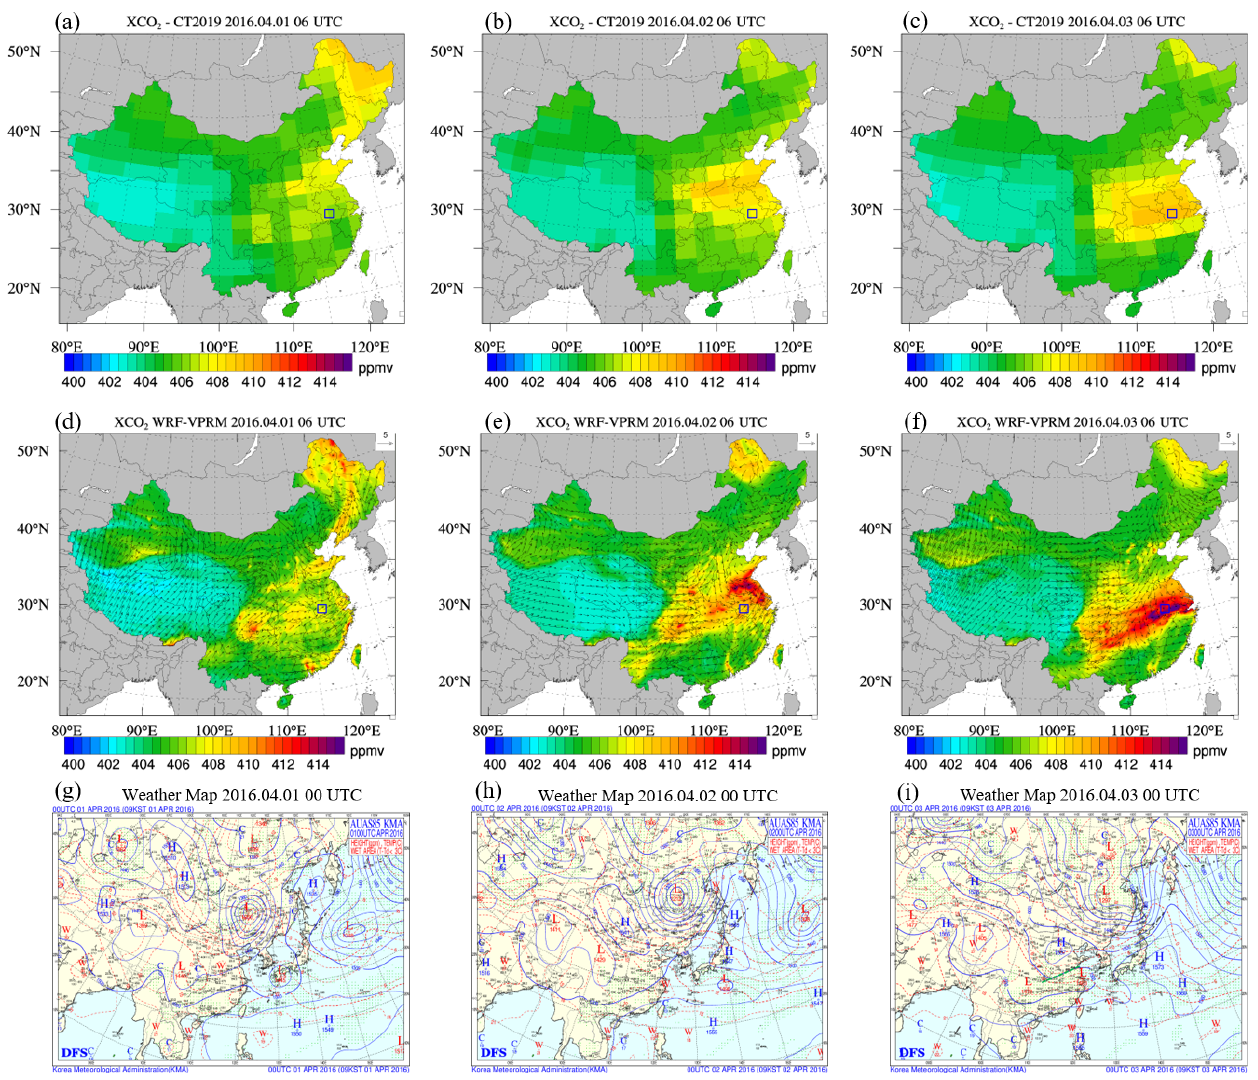
Figure 6. Daily XCO 2 from CT2019 (a–c) and WRF-Chem (d–f) . Weather map from the Korea Meteorological Administration (g–i) . The blue box represents the location of